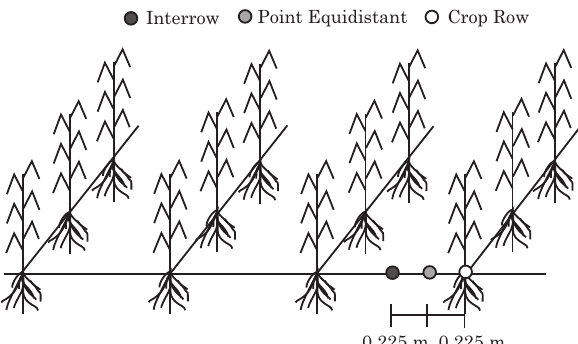
Figure 1. Schematic representation of the transect and sampling